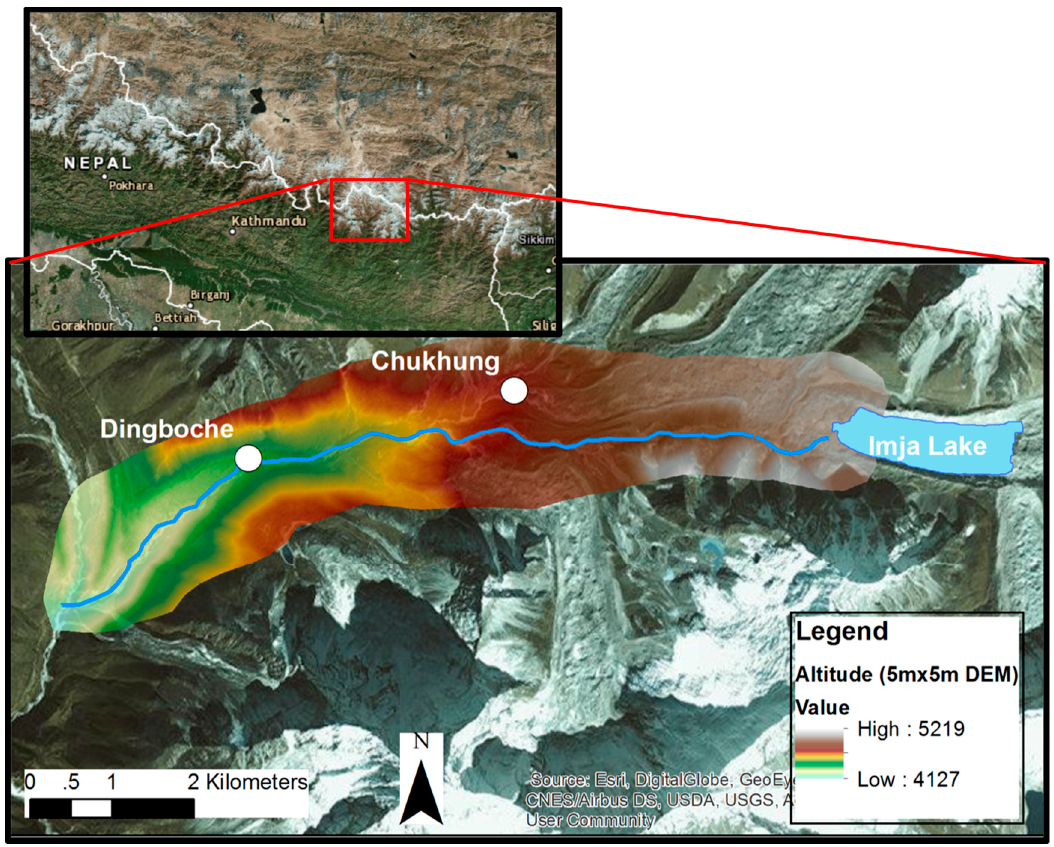
Figure 1. Map of Imja Lake and downstream communities in the Khumbu region of the Himalaya,